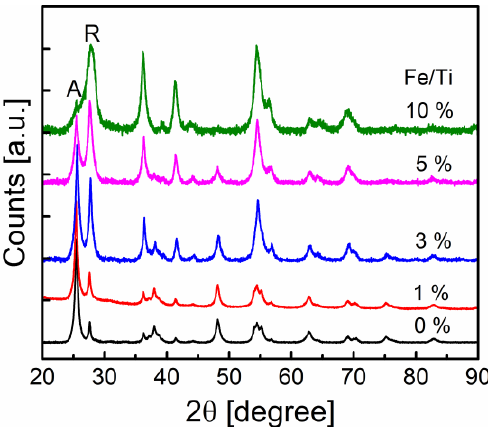
Figure 1. XRD spectra for iron-doped samples compared to pure TiO 2 nanoparticles.